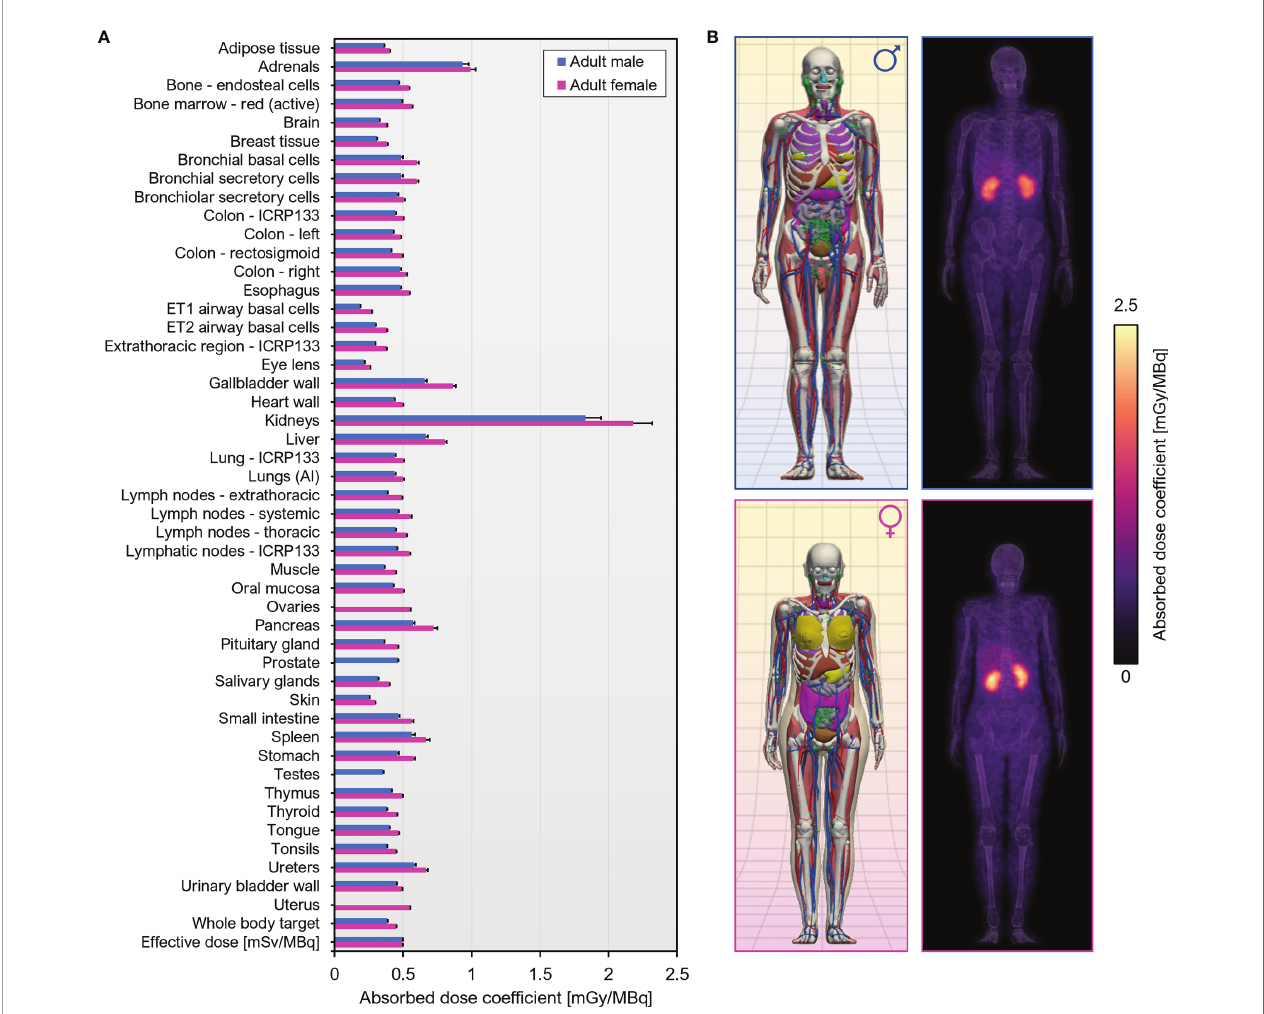
FIGURE 7 | Human dosimetry estimates for [ 89 Zr]Zr-DFO-Cys-Var3 projected from murine biodistribution. (A) Organ-level absorbed dose and effective dose coef fi cients computed for the ICRP 110 reference adult phantoms. Units are absorbed dose [mGy] per unit administered activity [MBq] unless otherwise speci fi ed. (B) Left, Computational phantoms used in dose calculations; Right, Maximum intensity projections of the 3D dose